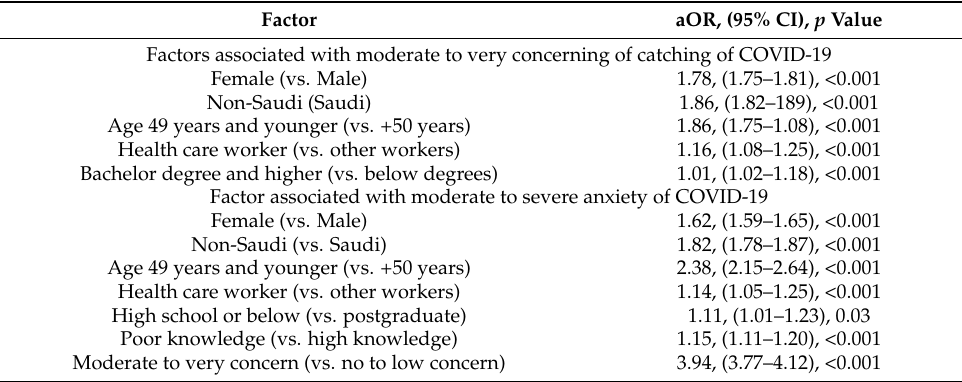
Table 5. Factors associated with concerning and anxiety levels among participants.